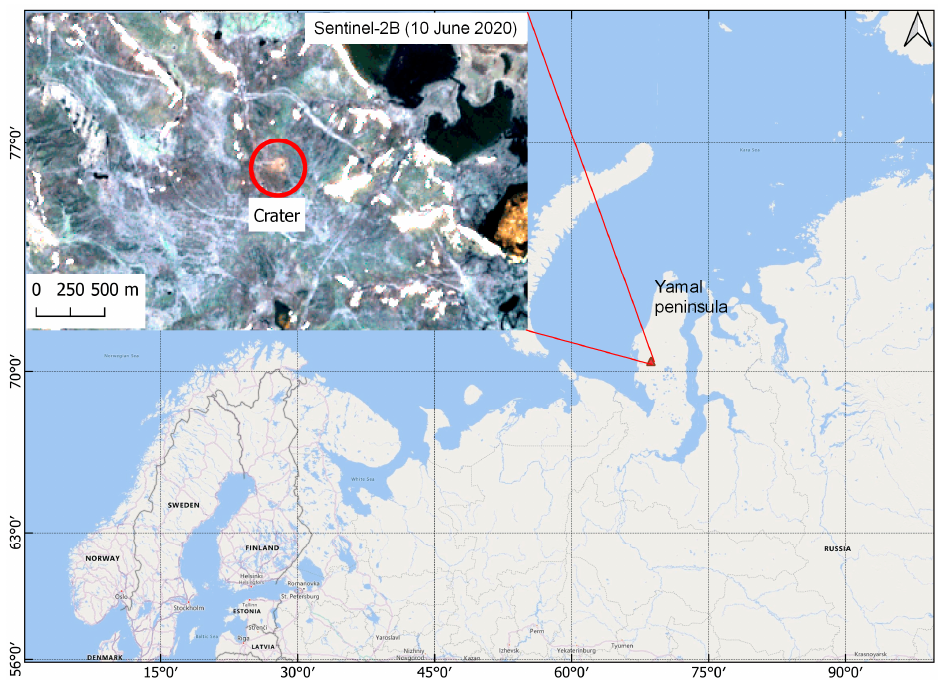
Figure 1. Location of the studied mound/crater and Sentinel-2B composite image after crater formation.